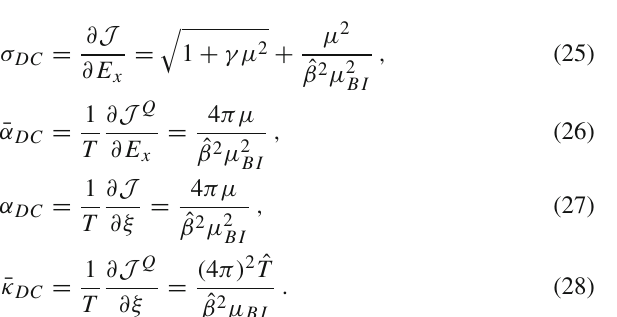
Fig. 2 α DC , ¯ α DC as the function of ˆ T for some specific γ and ˆ